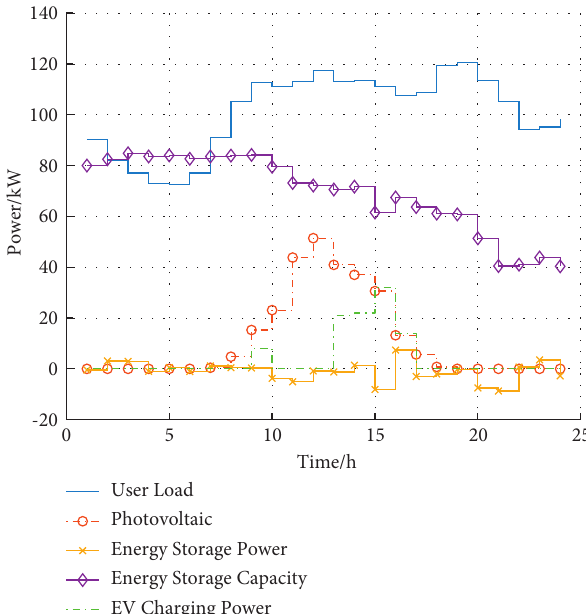
Figure 3: The running status of microgrid